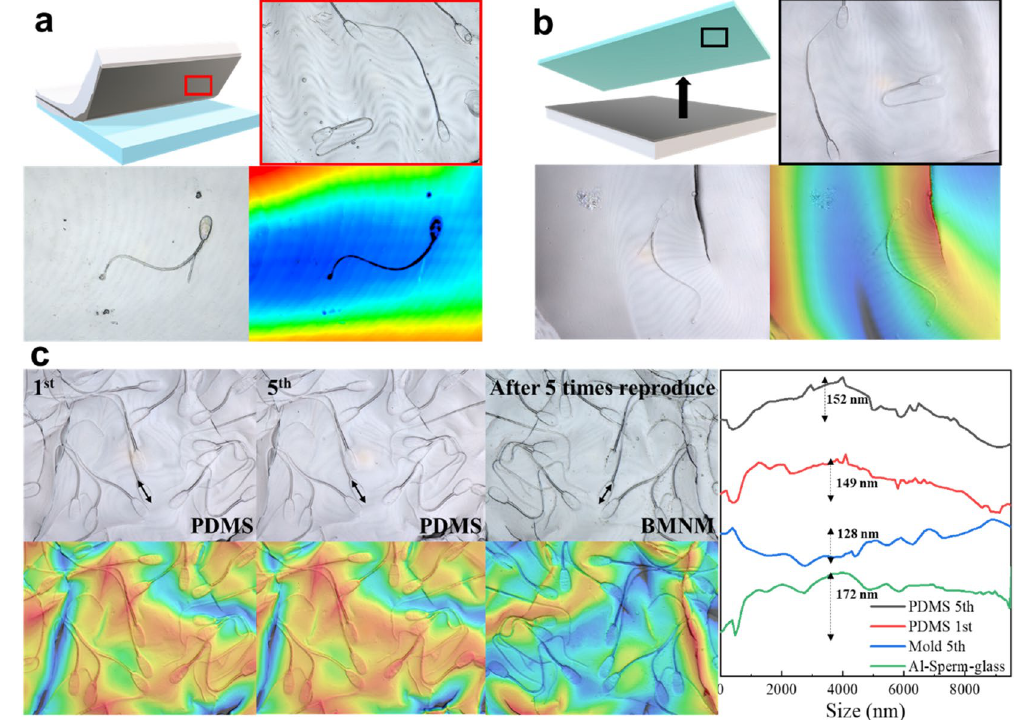
Figure 3. Shape reproduction analysis and observation of fabricated mould. ( a ) Schematic diagram shows stripping method for producing Al thin film from substrate using tapes; the surface of stripped film was analysed using a laser microscope (Red box). Height analysis of sperm with abnormally shaped middle pieces and tails. ( b ) Dimethylpolysiloxane (polydimethylsiloxane, PDMS) was poured into biomimetic metal nano- moulds (BMNM) to reproduce sperm surface shape. PDMS surface separated from the mould was optically analysed using laser microscopy (Black box). Height analysis of sperm with abnormally shaped middle pieces and tails. ( c ) Surface of the first and last PDMS bases; BMNMs were examined using laser microscopy after five replications using the same BMNM. Height of optical head surface was analysed using laser